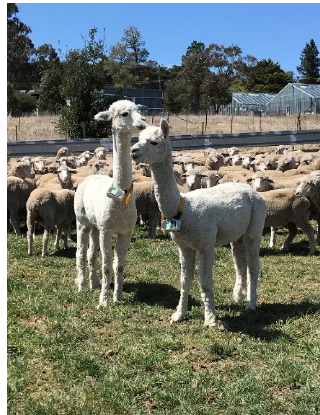
Figure 1. Study alpacas at the University of New England (Armidale, NSW, Australia) with Global Navigation Satellite System (GNSS) tracking collars attached.